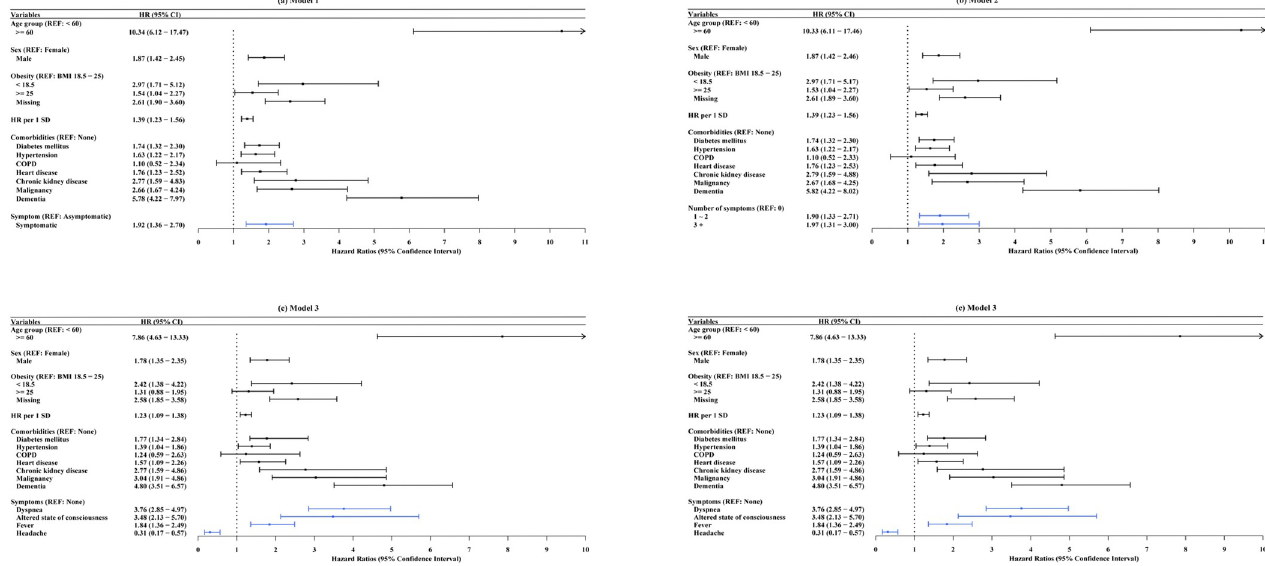
Fig 2. Multivariate cox regression of hazard ratios of in-hospital mortality in COVID-19 patients. (a) Model 1: HR of symptom presence adjusting for age group, sex, obesity, heart rate, and comorbidities; (b) Model 2: HR of the number of symptoms adjusting for age group, sex, obesity, heart rate, and comorbidities; (c) Model 3: HR of each significant symptom adjusting for age group, sex, obesity, heart rate, and comorbidities; (d) Model 4: HR of each factor score adjusting for age group, sex, obesity, heart rate, and comorbidities. Abbreviations: REF = reference; HR = heart rate; SD = standard deviation; BMI = body mass index; COPD = chronic obstructive pulmonary